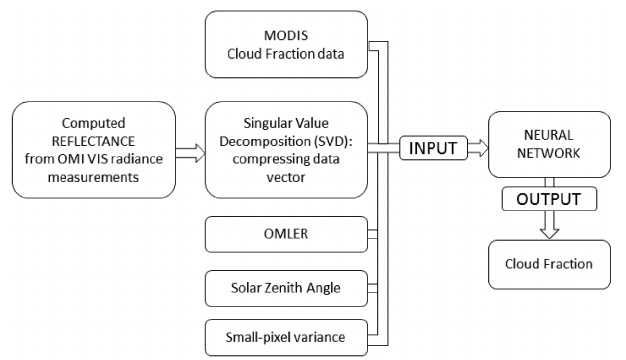
Fig. 2. Block diagram of the proposed approach for training the neural network. The training data set is composed of the target data represented by the MODIS cloud fraction re-gridded onto the OMI orbit, the compressed OMI reflectance vector data, and additional data such as climatological data (OMLER), the solar zenith angle and the computed small-pixel variance. These data form the input vector which is fed to the neural network. The neural network re- sponse is a predicted cloud fraction for the given orbit.